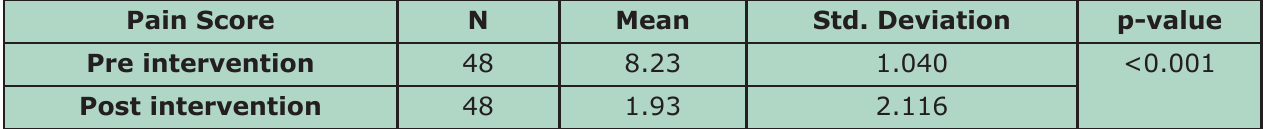
Table -II : Cortico-SteroidGroup ; Pre And Post Intervention Pain